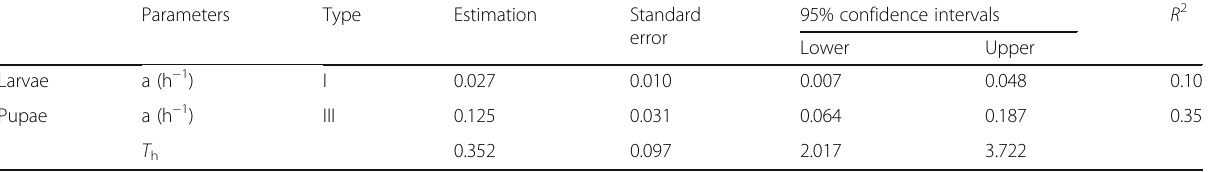
Table 4 Estimated values for A. biannulipes feeding on P. truncatus larvae and pupae Parameters